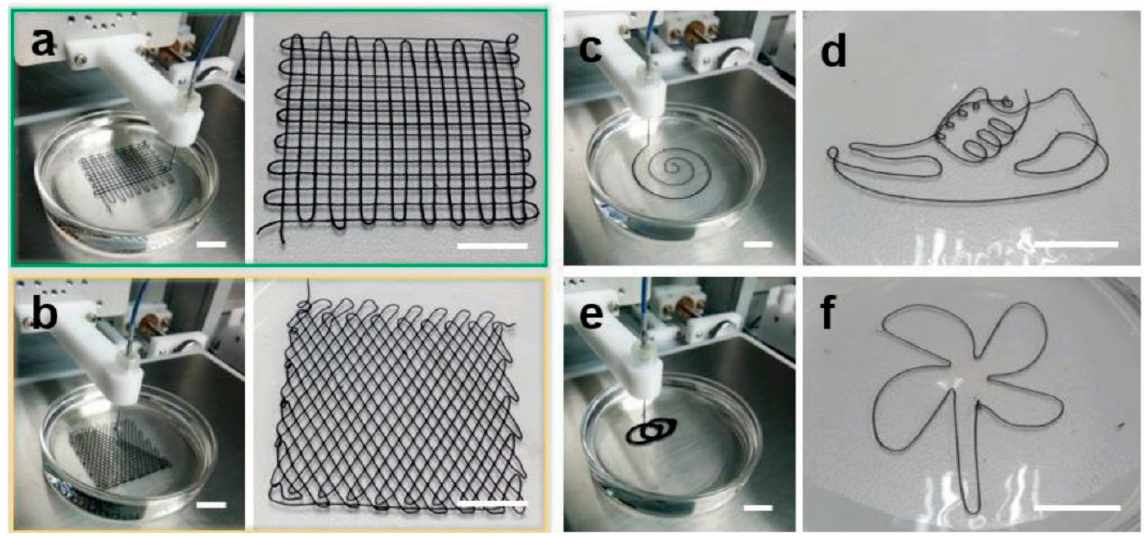
Figure 10. Optical images of the 3D-printed TOCNFs/Ti 3 C 2 fabrics with ( a ) woodpile and ( b ) fishing net structures. ( c – f ) Programmable printed TOCNFs/Ti 3 C 2 fibers with designed geometric structures, reprinted with permission from [120] .